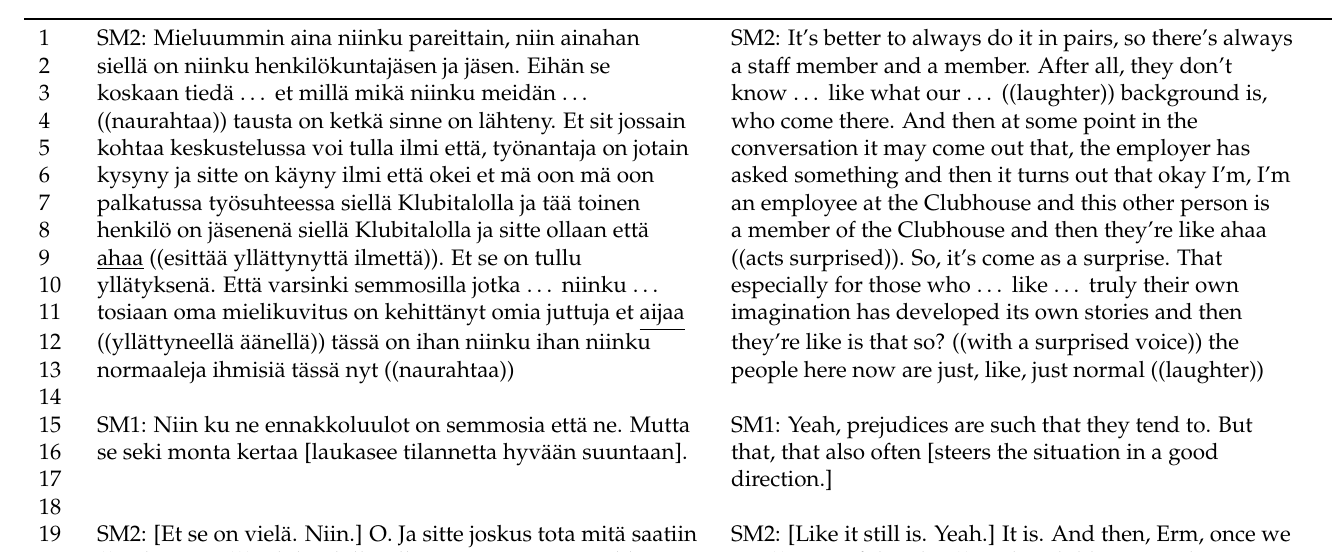
Table 4. Excerpt 2a.